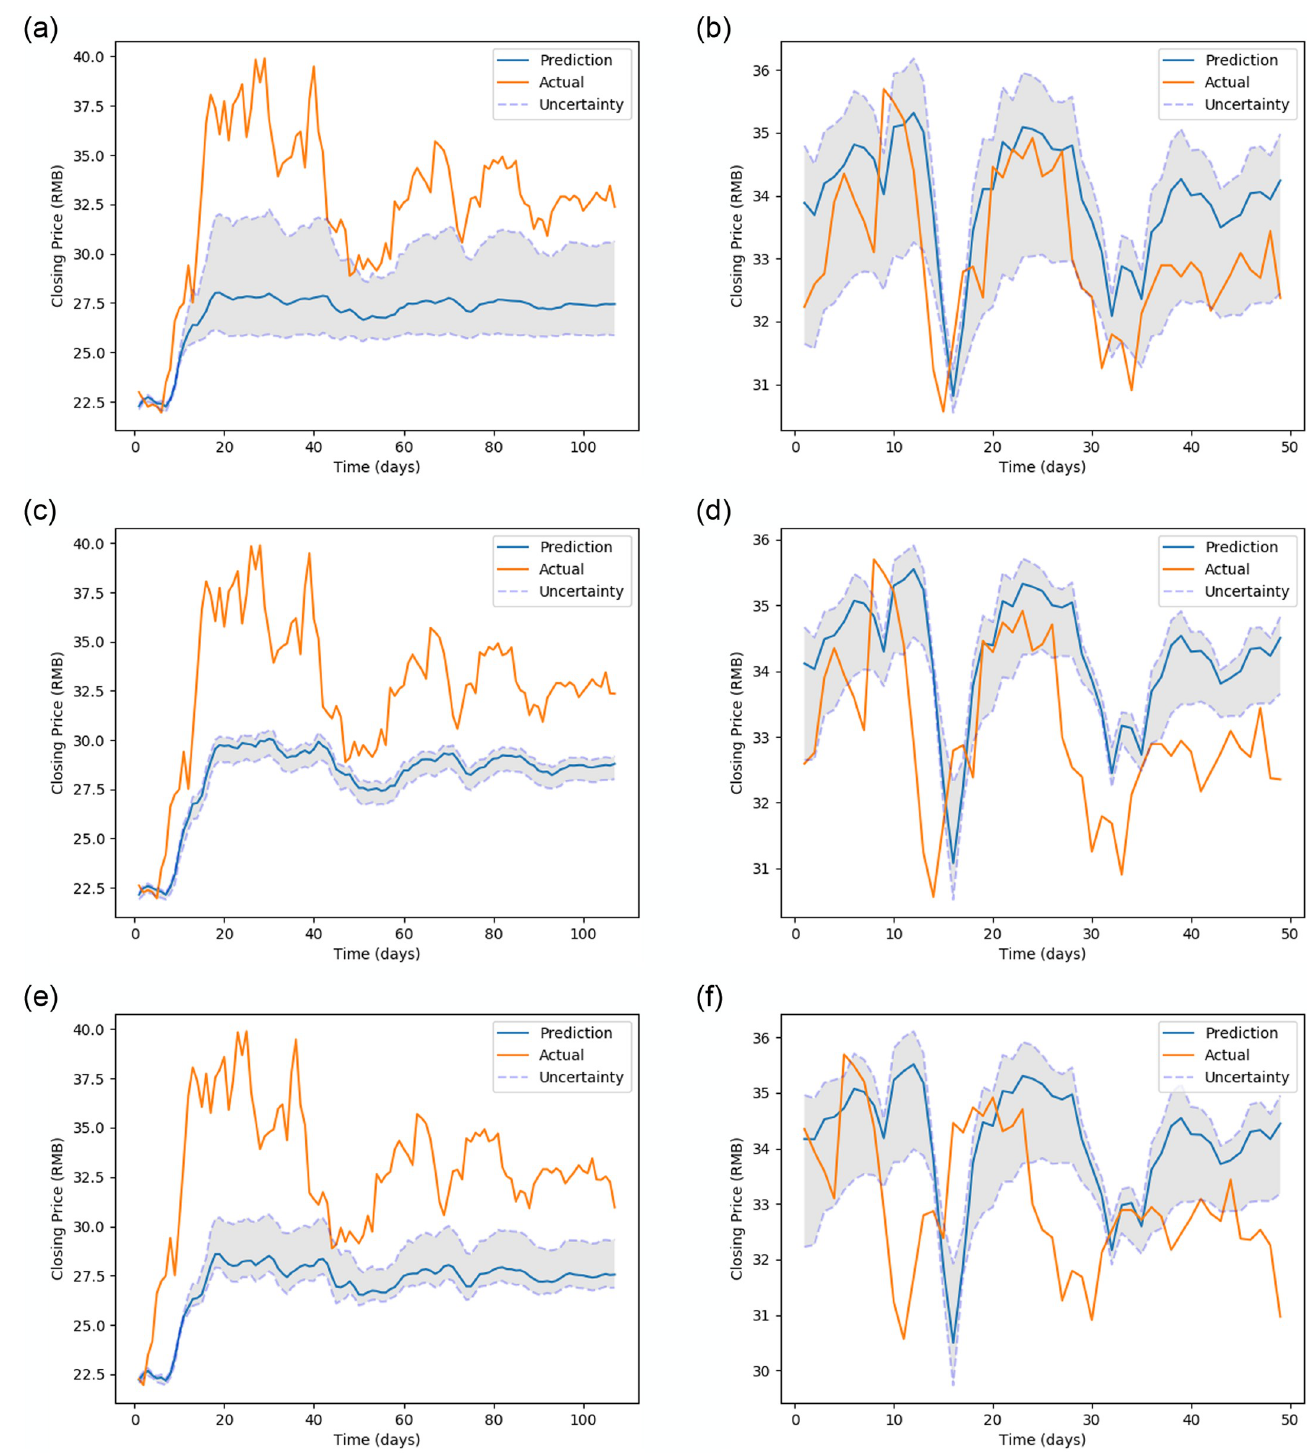
Fig 11. Prediction and uncertainty over test data of 600118.SS (data setup 1 vs data setup 2).